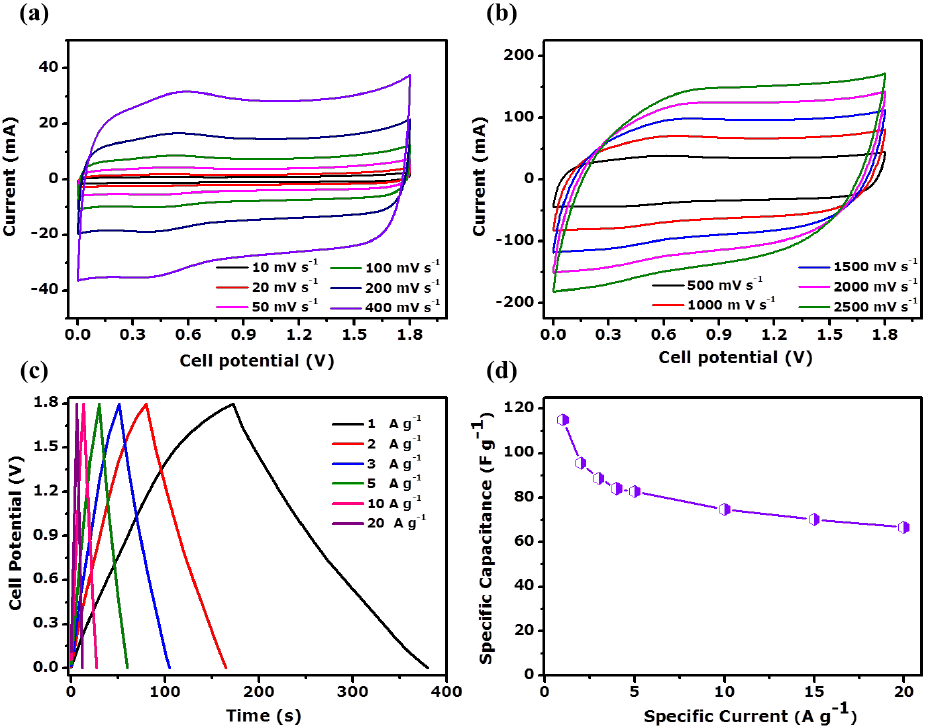
Figure 9. ( a , b ) Cyclic voltammetry at scan rates variant from 10–400 mV s −1 and from 500–2500 mV s −1 , respectively, ( c ) galvanostatic charge-discharge profiles at various specific currents from 1 to 20 A g −1 and ( d ) specific capacitance as a function of specific current for PAC/MoO 2 /Mo 2 C-1//PAC/MoO 2 /Mo 2 C-1 symmetric cell.